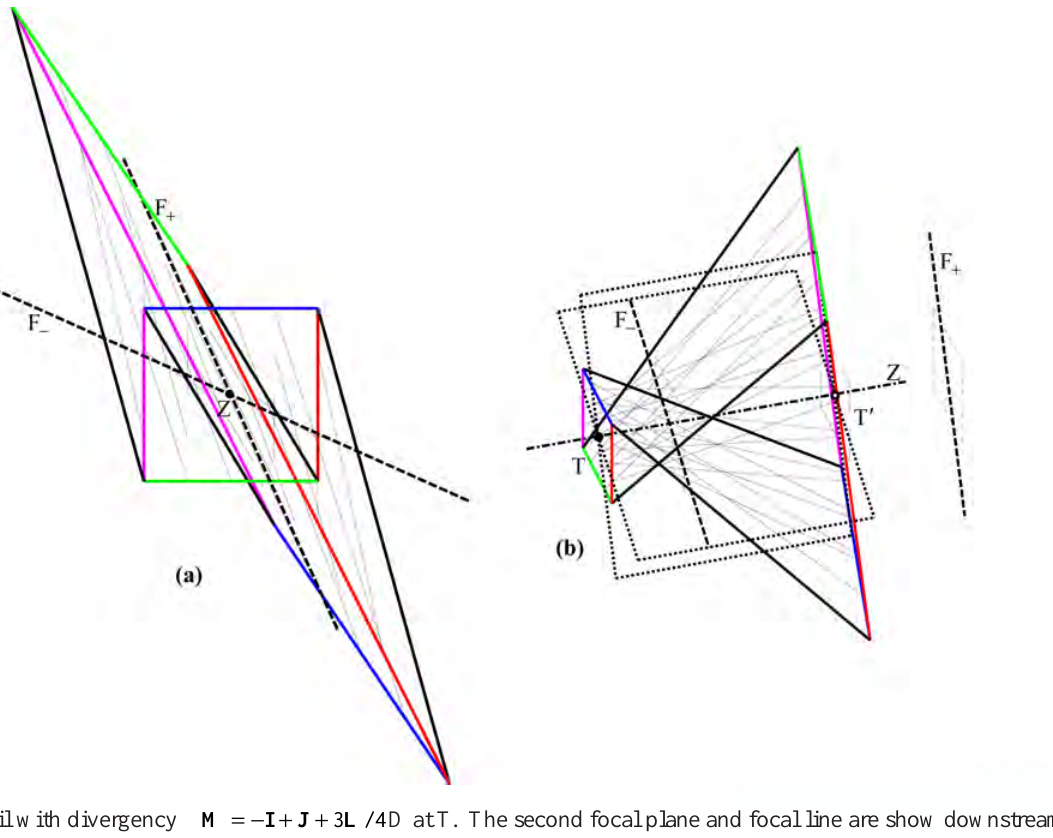
Figure 19 A pencil with divergency 4/3 LJIM ++−= D at T. The second focal plane and focal line are show downstream from the exit plane at a reduced distance of about 2.95 m. (b) azimuth °− 20 17 °− 20 , elevation 36 °− 20 The South African Optometrist